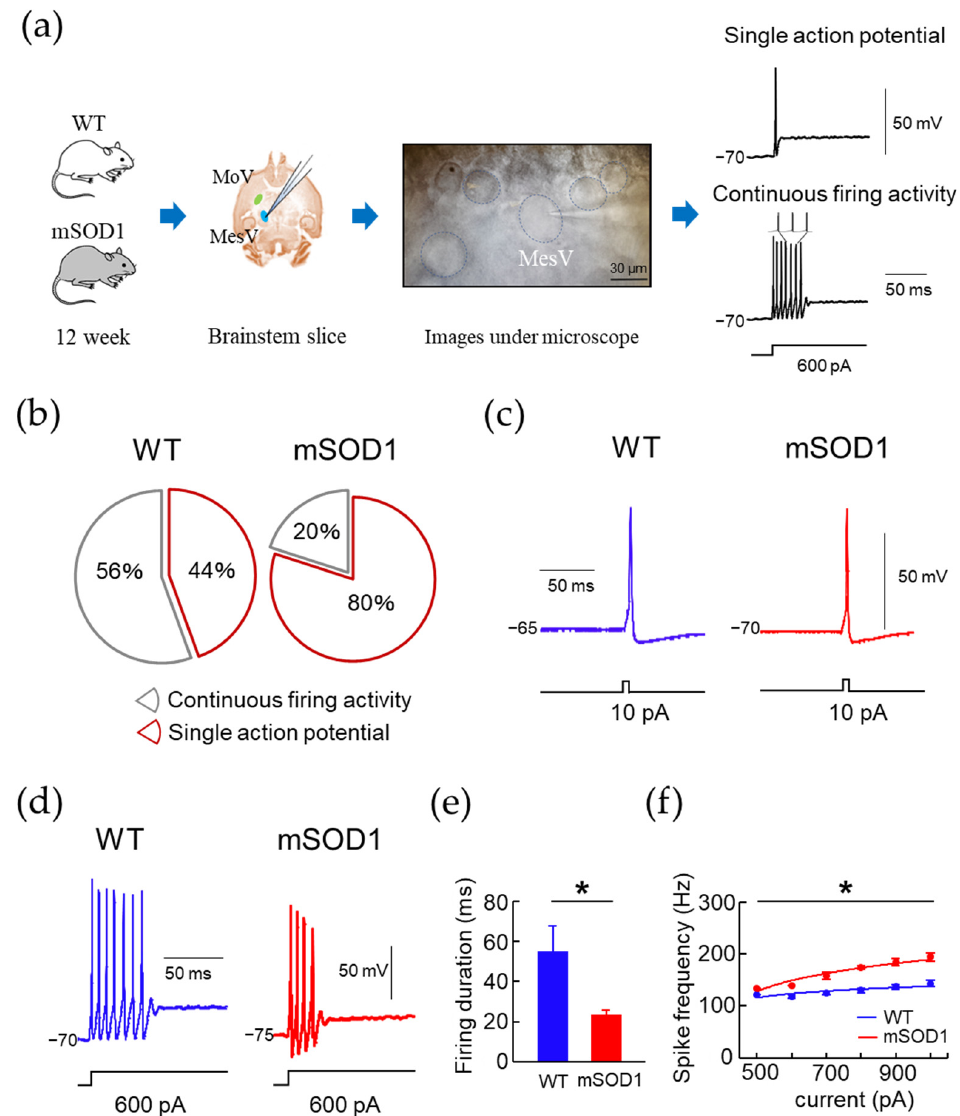
Figure 6. Whole-cell recording of MesV in a 12-week-old mouse model of ALS. ( a ) Schematic illustration of electrical recordings from MesV neuron showing “Single spiker” waveform and “Firing” waveform induced by a 600 pA square wave depolarizing pulse. ( b ) The “Single spiker” ratio was significantly higher in the mSOD1 group. ( c , d ) Action potential and continuous firing activity waveforms of WT and mSOD1 groups are shown. ( e , f ) Firing duration in the mSOD1 group was significantly shortened, while frequency in the 500–1000 pA injection current significantly increased. * p < 0.05.